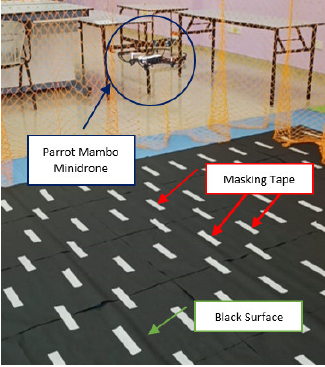
Figure 13. Test field and a Parrot Mambo Minidrone during execution. Table 4. Experiment performance index for PID, APID, and APIDFC.